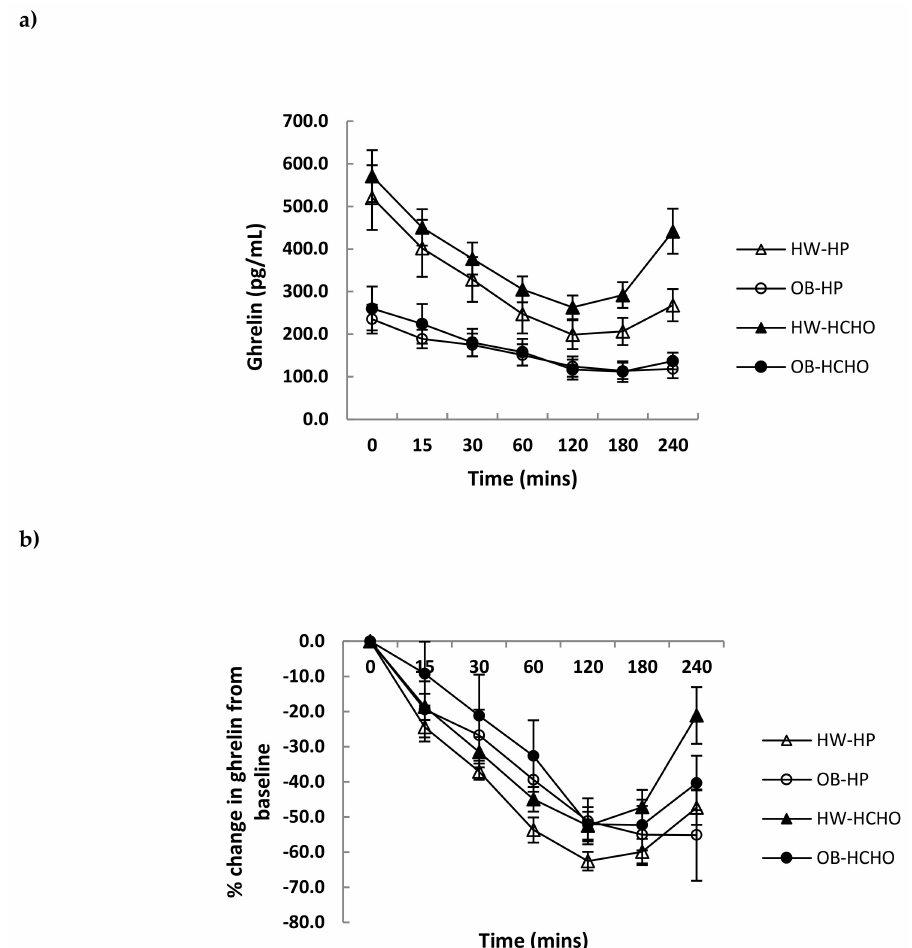
Figure 2. Changes in plasma ghrelin concentrations over time after a high-protein (HP) and high-carbohydrate meal (HCHO) in adolescents with obesity (OB) n = 8 and of healthy weight (HW) n = 12. ( a ) ghrelin: Effect of time ( p = 0.001) and time x weight interaction ( p = 0.044); ( b ) ghrelin (percentage change from baseline): Effect of time ( p < 0.001) and meal ( p = 0.018). Data analysed using a mixed between–within-subjects analysis of variance. Data are presented as means (SEM).